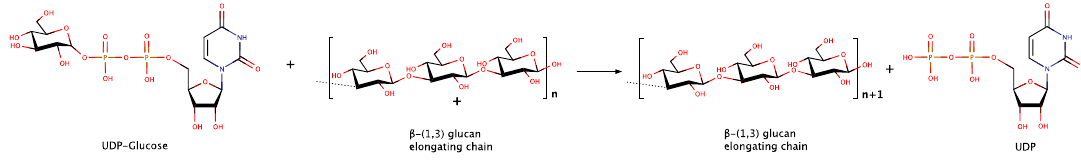
Figure 2. β -(1,3) glucan chain elongation reaction catalyzed by GLS.